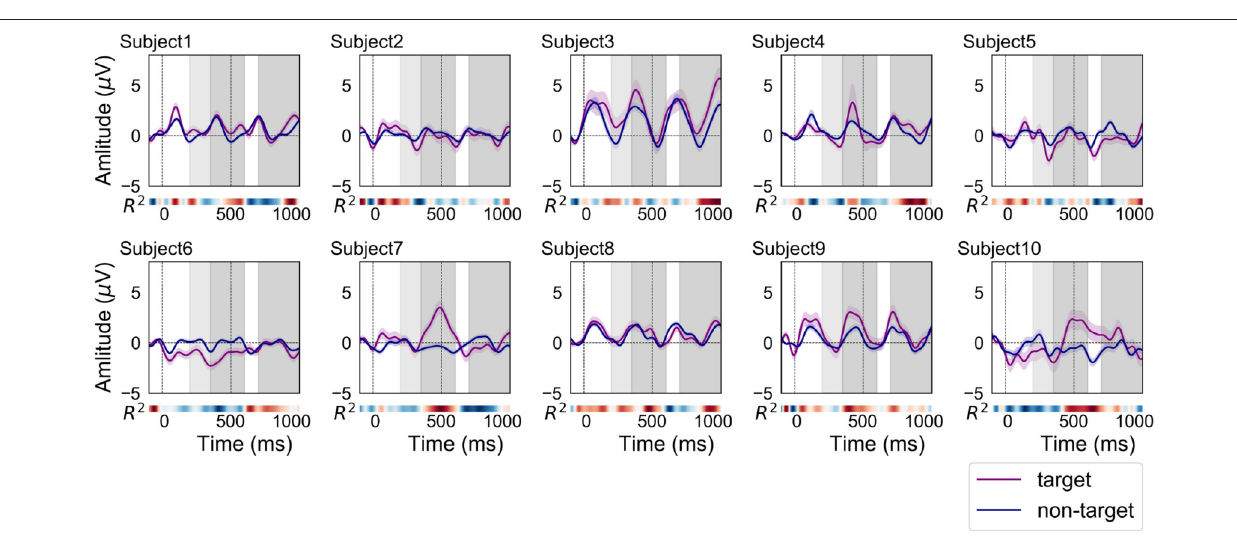
FIGURE 4 | ERP and non-ERP waveforms of each subject in the online analysis 1 (purple line: ERP, blue line: non-ERP). The filled fields along the plots denote the standard error (SE) of amplitudes for each time point. The time interval for N200 is filled with light-gray color at 200–350 ms. In addition, the time intervals between 350–600 and 700–1,000 ms were filled with dark-gray color for finding the positive peaks of ERP